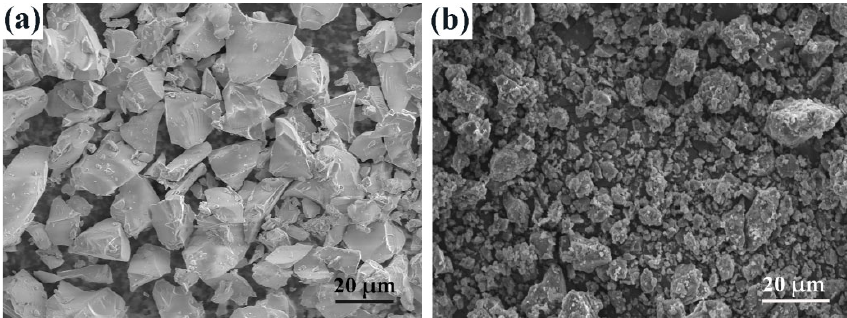
Figure 1. SEM images of SGFs ( a ) and STPP ( b ).